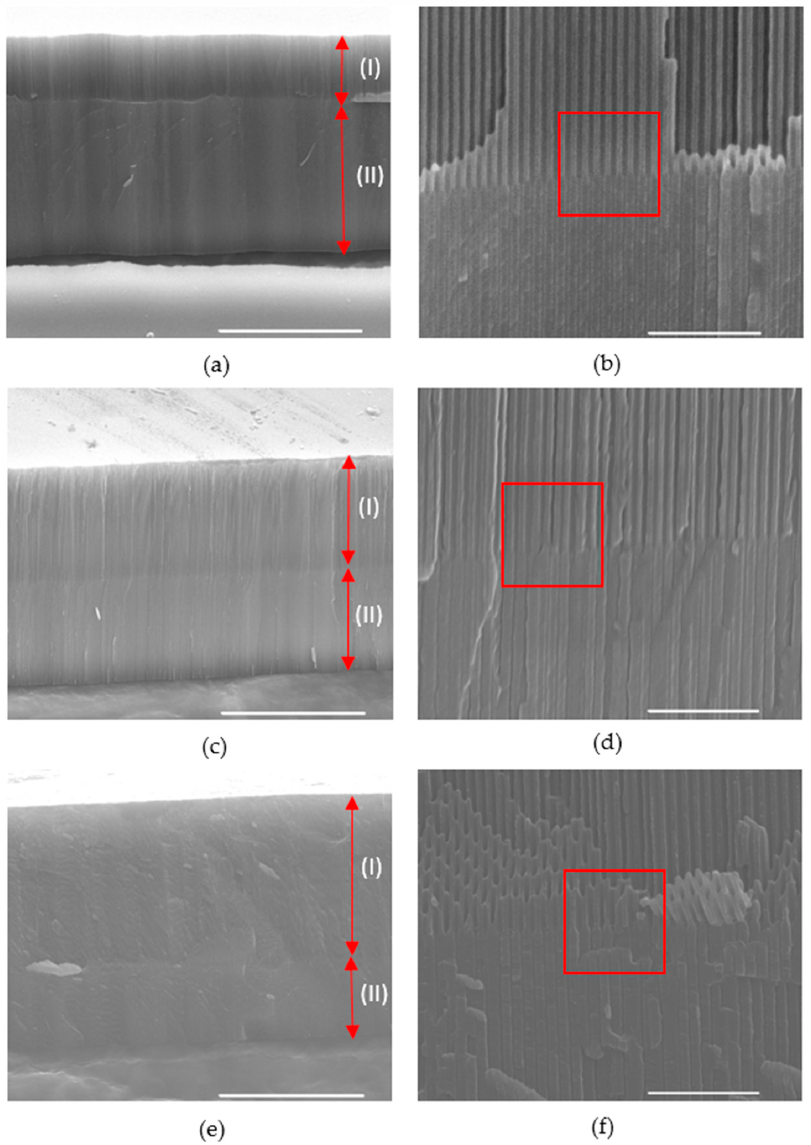
Figure 2. Scanning electron microscopy (SEM) structural characterization of fabricated BL-NAAs showing the length of pore layers and pore diameters. ( a ) Cross-section view of BL-NAA (25/75) , scale bar is 20 μ m. ( b ) Cross-section view of BL-NAA (25/75) , scale bar is 1 μ m. ( c ) Cross-section view of BL-NAA (50/50) , scale bar is 20 μ m. ( d ) Cross-section view of BL-NAA (50/50) , scale bar is 1 μ m. ( e ) Cross-section view of BL-NAA (75/25) , scale bar is 20 μ m. ( f ) Cross-section view of BL-NAA (75/25) , scale bar is 1 μ m.